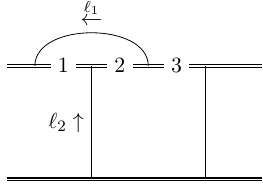
Figure 7. Linear mushroom